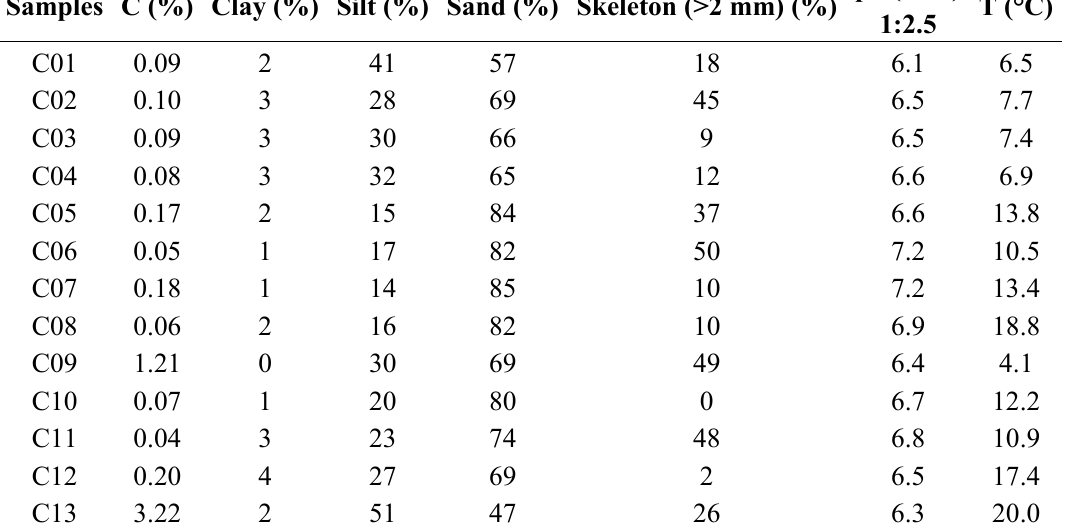
Table 2. Selected soil properties of the crust